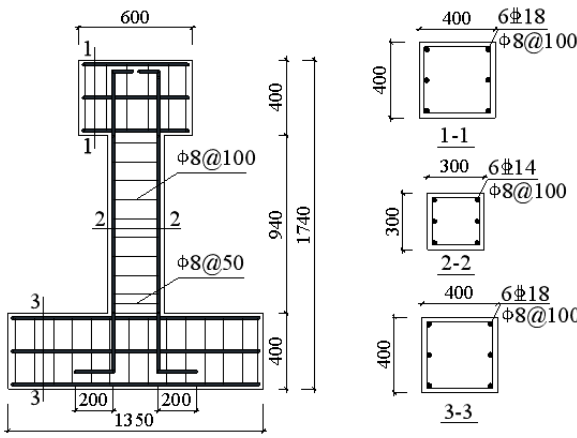
Figure 1: Specimen size and reinforcement